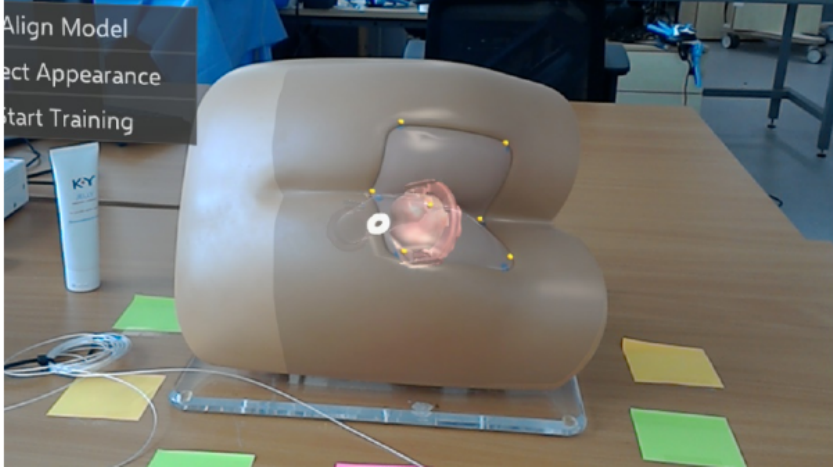
Figure 8. A virtual transparent benchtop model with a 3D virtual prostate inside is aligned with the physical benchtop model.